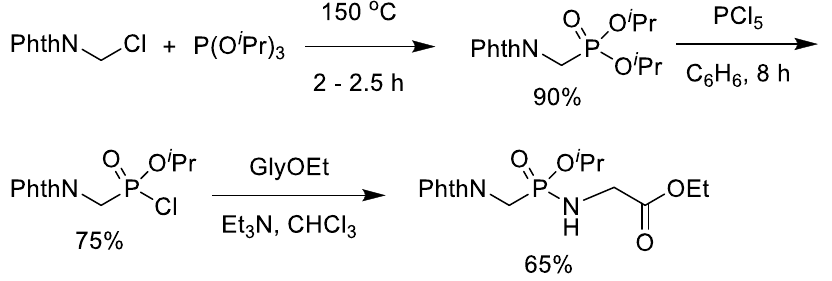
Scheme 1. First synthesis of phosphonopeptide.